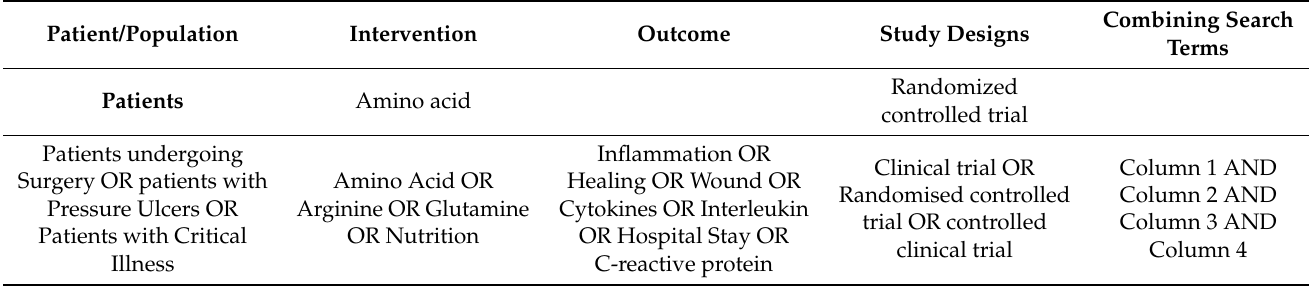
Table 1. Search terms and search